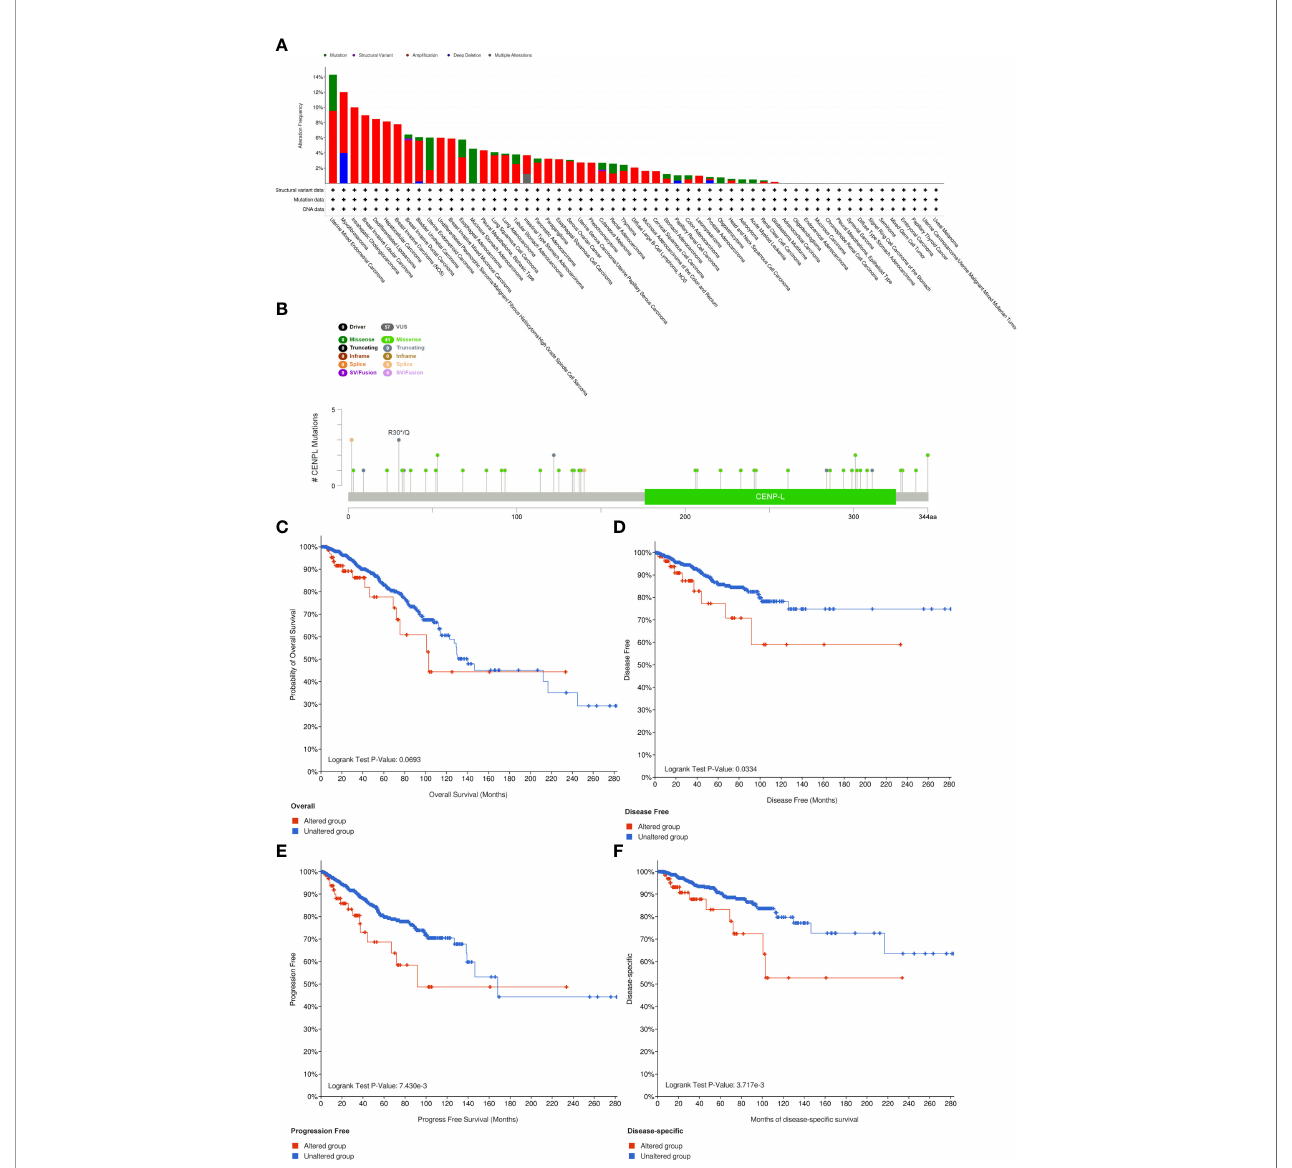
FIGURE 4 | The mutation character of CENPL in pan-cancer. (A) Alteration frequency of CENPL in pan-cancer. (B) The subtypes and distributions of CENPL somatic mutations. (C – F) OS, DFS, PFS, and DSS analysis strati fi ed by CENPL mutation status in breast invasive